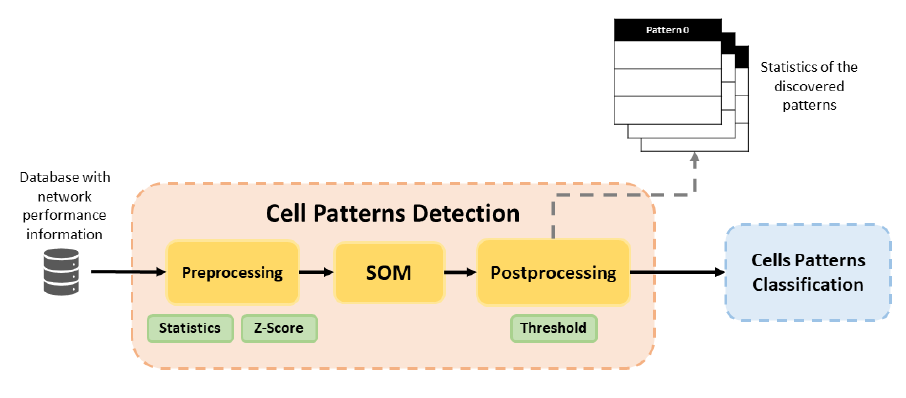
Figure 2. Block diagram of training phase in the proposed